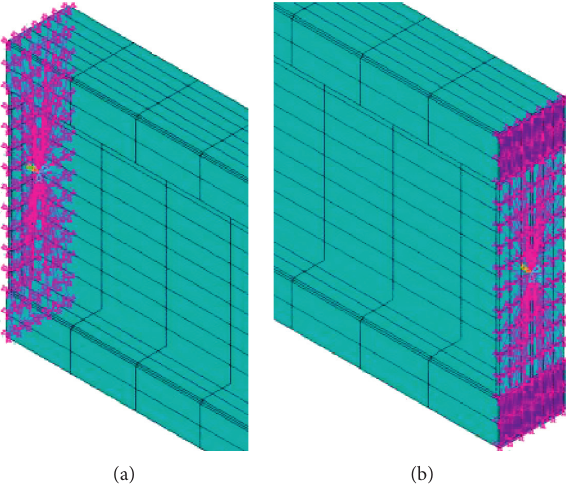
Figure 9: Boundary conditions. (a) Left end support. (b) Right end support.